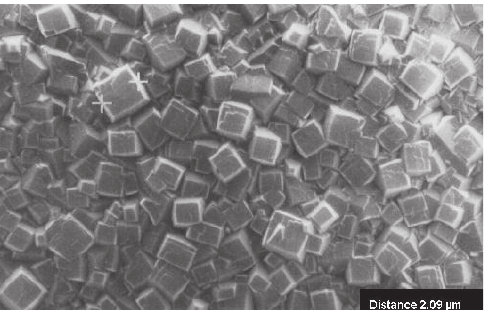
Figure 6. Polycrystalline layer of cubic crystals of diamond, deposited in an ICP reactor at 3 Torr and RF power input of 1200 W, Ar:H 2 :CH 4 = 250:25:0.5 sccm. The bar represents 2.09 µ m [33] (with kind permission from Peter Awakowicz, 2021).